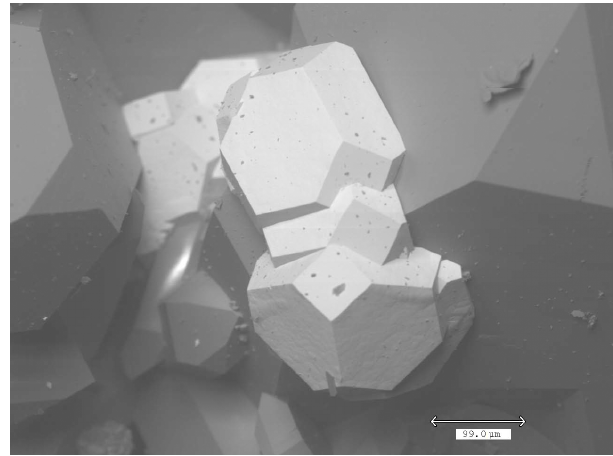
Table 1. Chemical data for